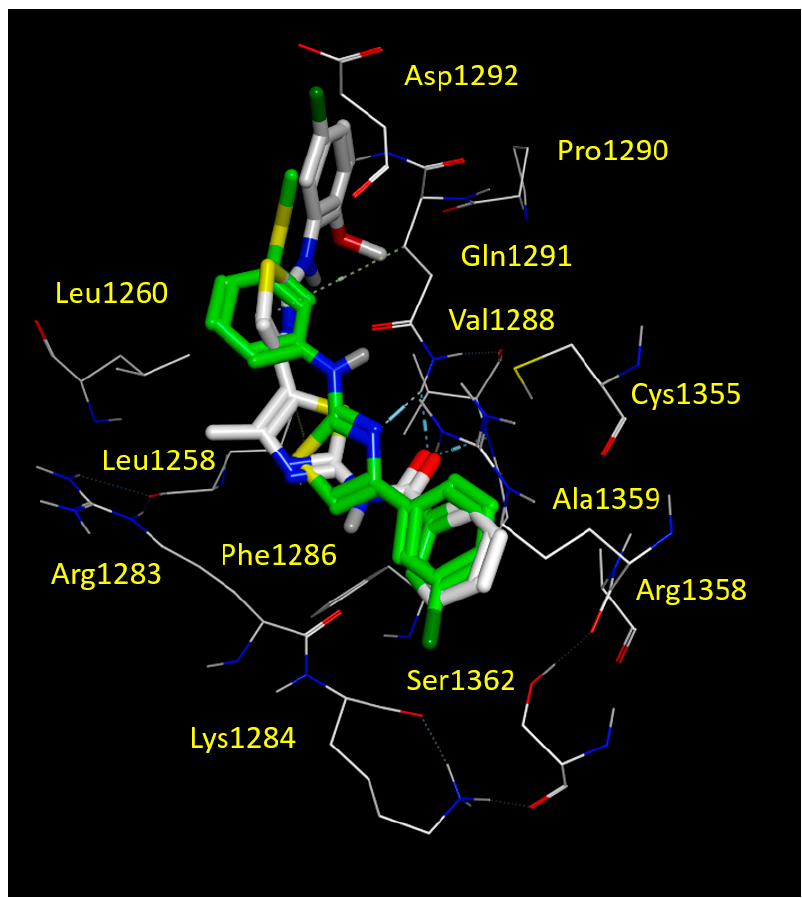
Figure 7. Docking positioning of corrector corr4a (C atom; white) and FCG (C atom; green) at the CFTR NBD2 domain (PDB code = 6UK1). All residues placed 3.5 Å from the ligands are shown. Hydrophobic, polar, negatively and positively charged amino acids are shown in green, pink, and by red and blue circled pink labels, respectively.